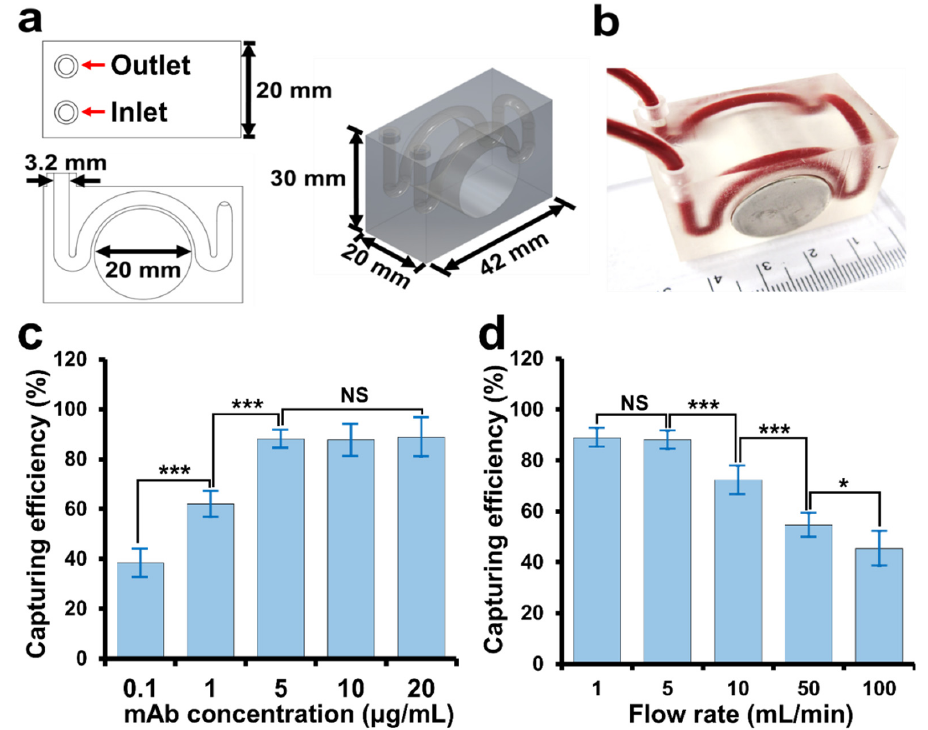
Figure 2. Fabrication and optimization of 3DPIC. ( a ) Design and ( b ) printed image of 3DPIC. The 3DPIC consists of a round channel with a diameter of 3.2 mm and a cylindrical hole holding a permanent magnet (diameter, 20 mm). ( c ) Effect of the concentration of mAb on the capturing efficiency of Caco-2 cells by 3DPIC. Two hundred microliters of MNPs (10 10 particles/mL, final conc.) that were previously conjugated with mAb at different concentrations (0.1–20 µ g/mL) in PBS were mixed with Caco-2 cells (10 4 cells/mL, final conc.) in 10 mL of PBS and incubated at 37 °C on an orbital shaker at 200 rpm for 20 min. Then, the mixture was injected into 3DPIC at 5 mL/min. The captured cells were counted using the ATP luminescence assay. ( d ) Capturing efficiency of CTCs (10 4 cell/mL) in 10 mL of PBS at different flow rates (1–100 mL/min) with MNPs conjugated with the mAb at 5 µ g/mL. Student’s t -test, NS: non-significance, *: p < 0.05, and ***: p < 0.001. Sample number ( n ) =